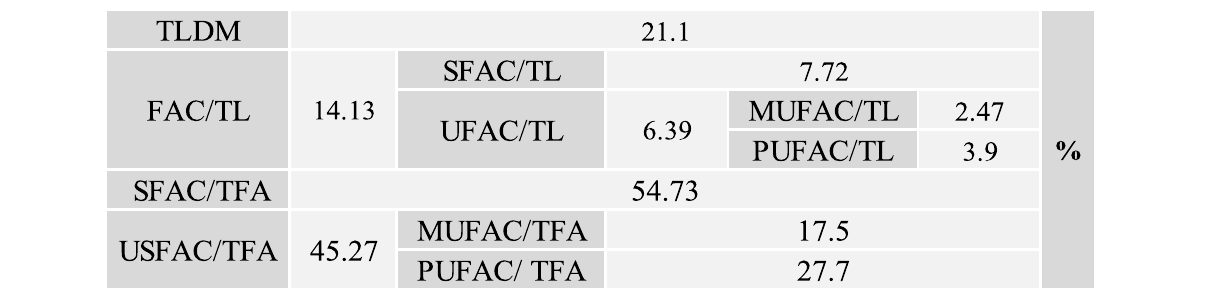
Table 3 Total lipid content as percentage of dry mass (TLDM), saturated fatty acid content as percentage of total lipids (SFAC/TL) and total fatty acids (SFAC/TFA) and monounsaturated and polyunsaturated fatty acid content as percentages of total fatty acids (MUFAC/TFA and PUFAC/TFA, respectively) and of total lipids (MUFAC/TL and PUFAC/TL, respectively) and total fatty acid contents